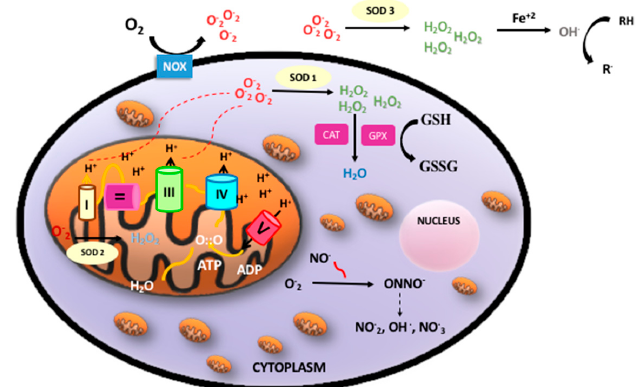
Figure 1. Oxidative phosphorylation, reactive oxygen species (ROS)/reactive nitrogen species (RNS), and antioxidant defense. Oxidative phosphorylation in the mitochondria builds up adenosine triphosphates (ATP) from highly energized electrons from the Krebs’ cycle. The antioxidant system: Superoxide anion (O 2 − ) mainly produced in the mitochondria is dismutated to hydrogen peroxide (H 2 O 2 ) by superoxide dismutase (SOD1 intracellular, SOD2 mitochondrial, SOD3 extracellular). H 2 O 2